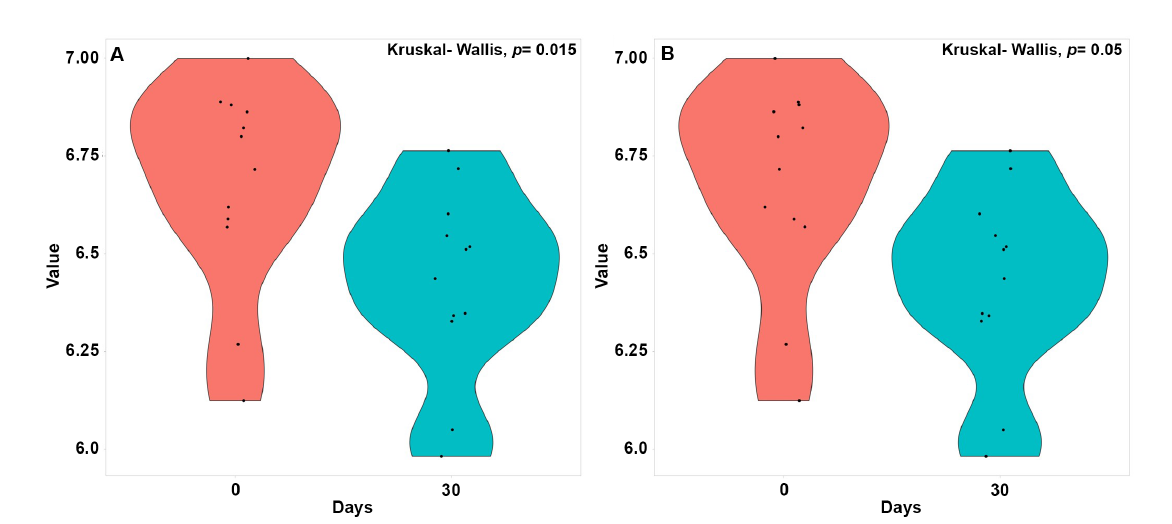
Figure 2. Daywise comparison of alpha diversity indices. ( A ) Shannon and ( B ) Simpson indices based on the gut microbiota of mice on 0th and 30th days of different treatments.